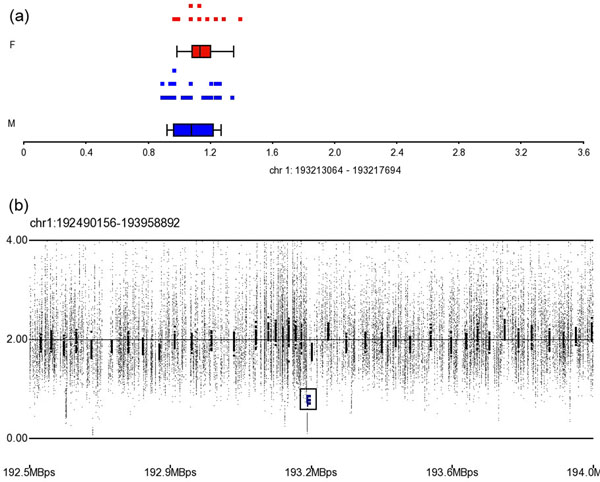
The CN state and SNP array profile graph of loss CNV region on 1q31.2. (a) The distribution of CNs in the loss CNV region on 1q31.2. Blue and red dots indicate male and female patients, respectively; (b) SNP array profile for part of 1q31.2; the black box marks the location of this CNV region.